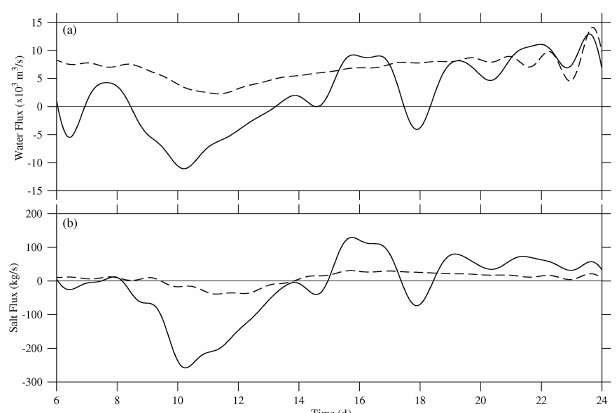
Figure 8. Temporal variations in residual water flux (a) and salt flux (c) across sec1 in the northern channel from February 6 to 24 2014. Dashed line – experiment 1; solid line – experiment 2. A pos- itive value represents seaward flux, and a negative value represents landward